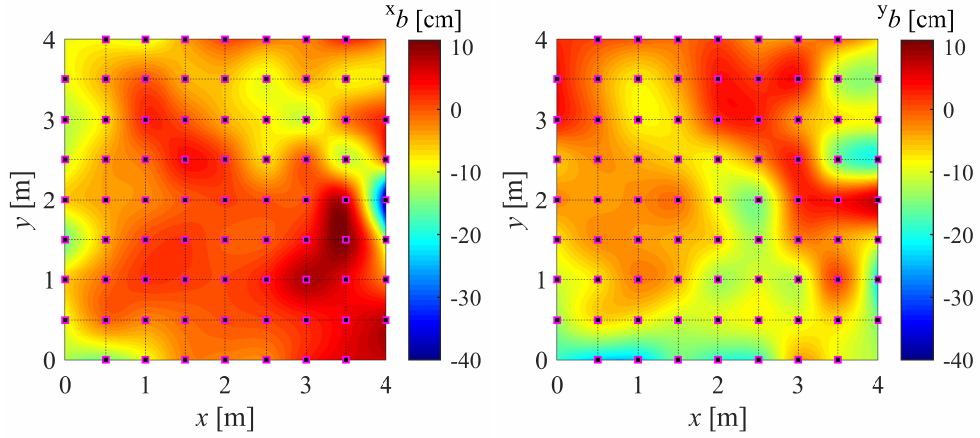
Figure 11. Accuracy map of x component ( ± x b ) and y component ( ± y b ) of